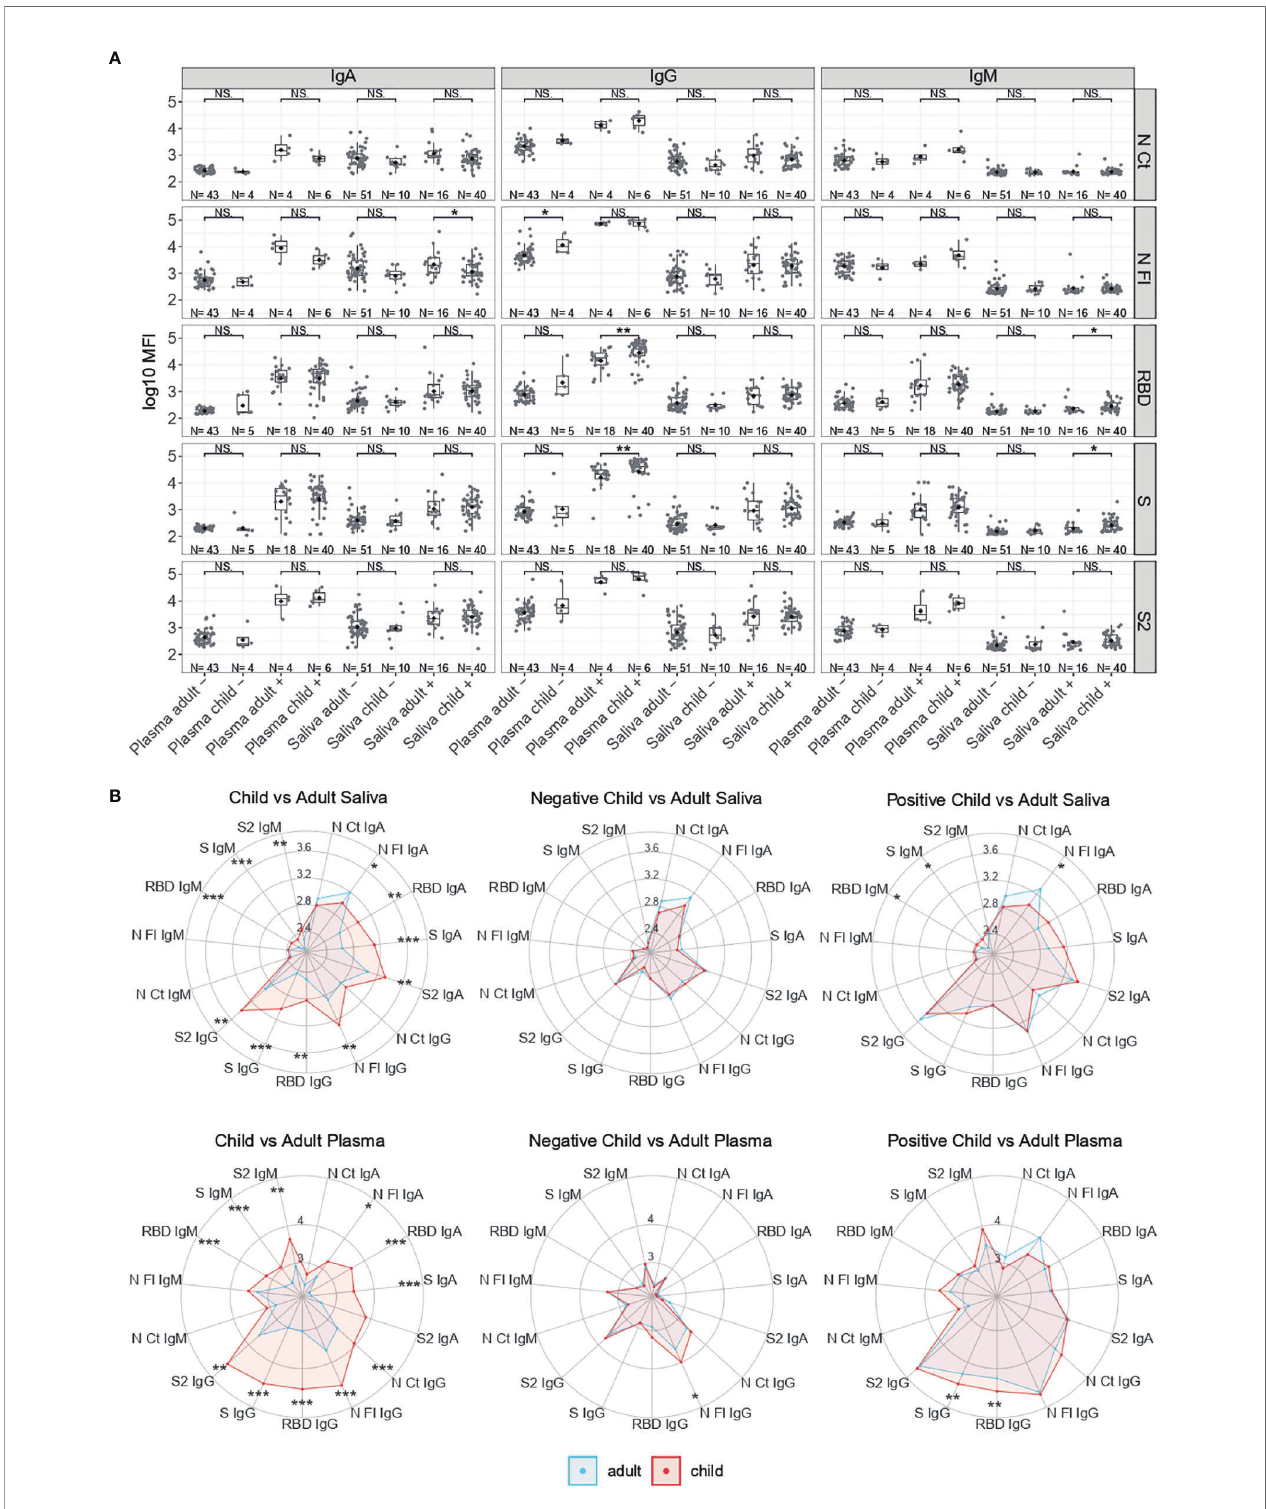
FIGURE 2 | Antibody levels according to SARS-CoV-2 RT-PCR status and by age. (A) Boxplots showing log 10 MFI antibody levels of saliva samples tested heat inactivated and at 1/10 dilution, and serum (from plasma samples or dry blood spots) at 1/500. (B) Radar charts comparing the medians of antibody levels (in log 10 MFI) between child and adult plasma and saliva samples Adults are represented in blue and children in red. Median log 10 MFI antibody levels were compared by Mann-Whitney U test. Statistically signi fi cant raw p-values are highlighted with asterisks. ***p < 0.001, **p < 0.01, *p < 0.05, NS, not signi fi